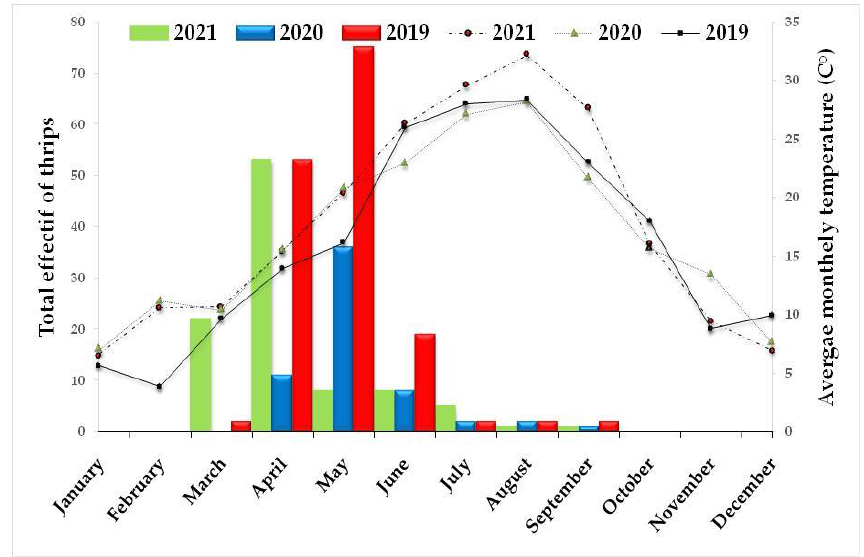
Figure 4. Temporal fluctuation of thripsadultson olive trees in Batna region according to monthly average temperatures.